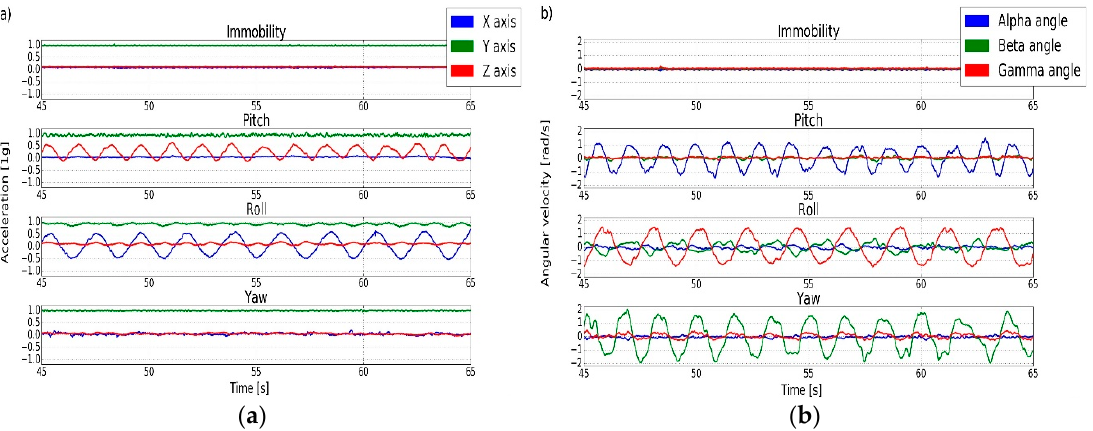
Figure 2. Example signal waveforms recorded by: ( a ) acceleration sensors and ( b ) gyroscope sensors.